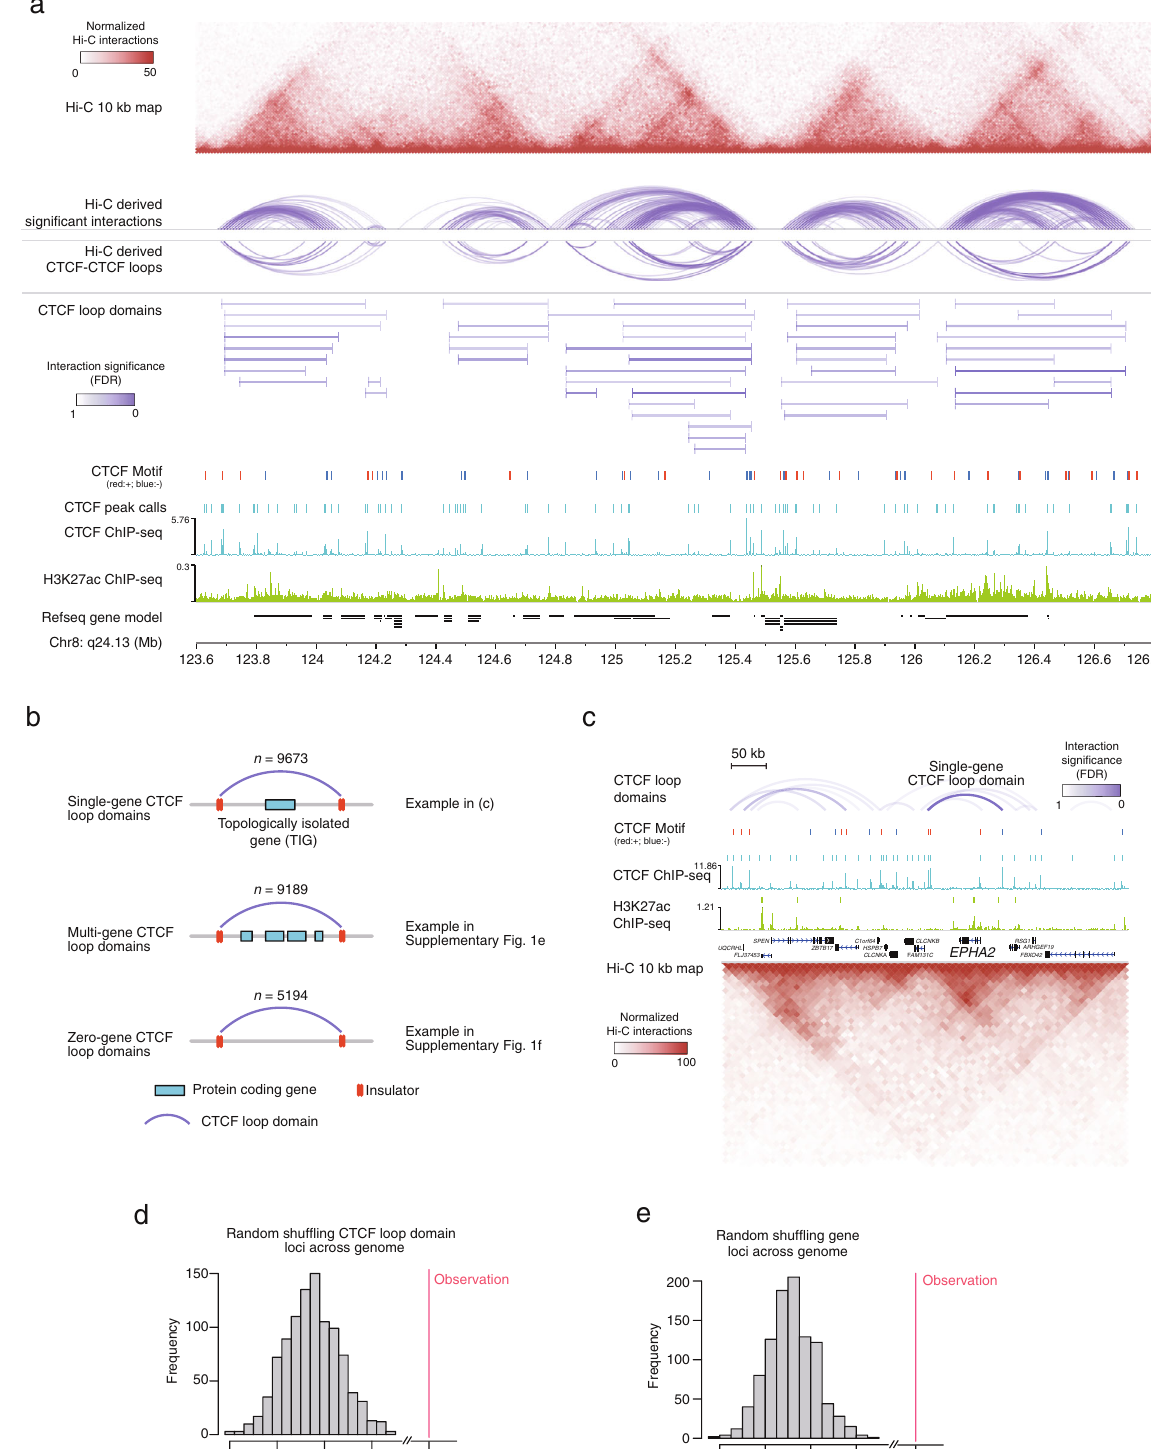
same time. We therefore used boundary-anchored virtual 4 C plots to visualize contact interactions between all pairs of boundaries in a sample. This approach uses two heatmaps, with the left heatmap representing the Hi-C interactions from the surrounding genomic regions of the left boundaries to the right boundaries (similar to setting the left boundaries as viewpoints in